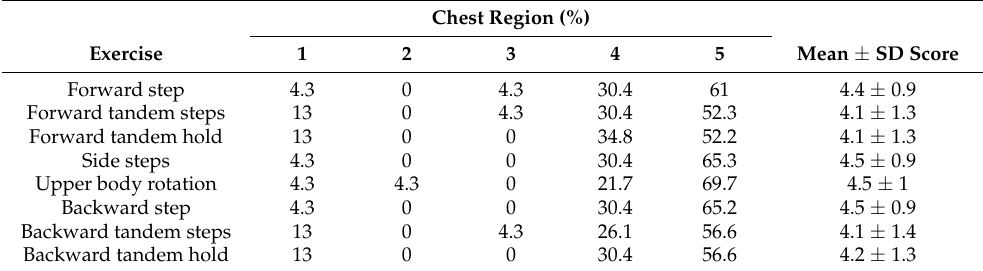
Table 6. Enjoyment scores of the exercises performed at the chest